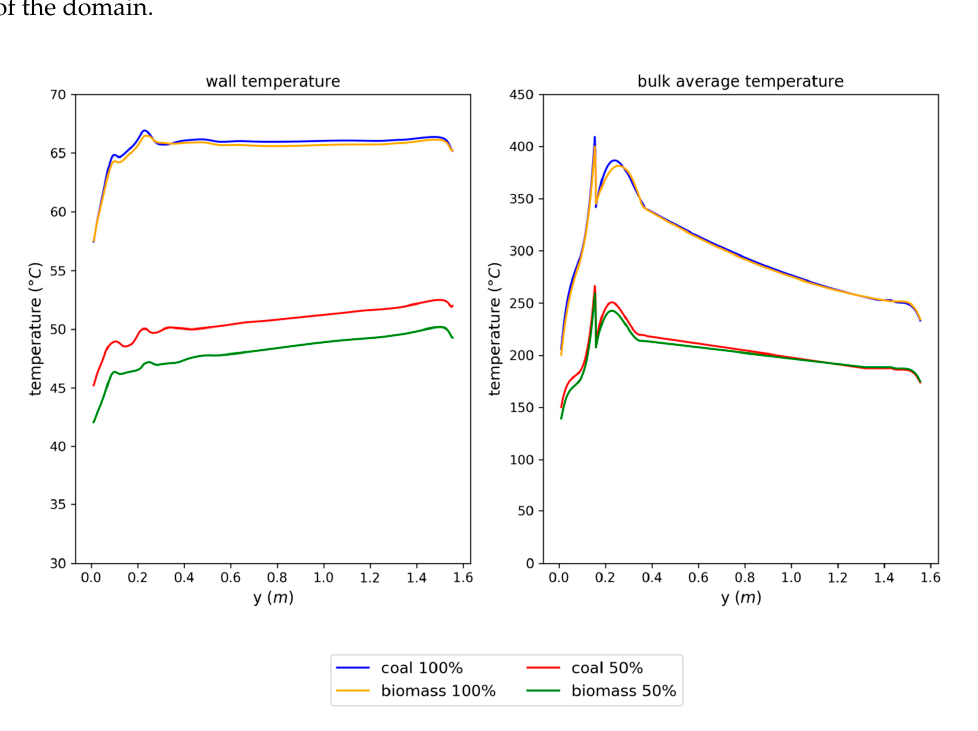
Table 4. Comparison of crucial parameters obtained in numerical and experimental (analytical) part of the research.